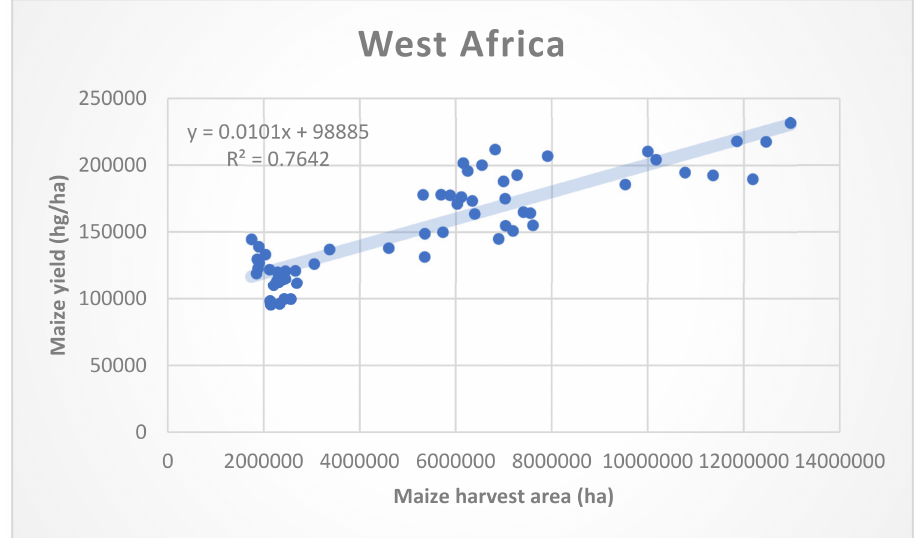
Figure 5. Scatter plot of the relationship between maize yield and harvest area in West